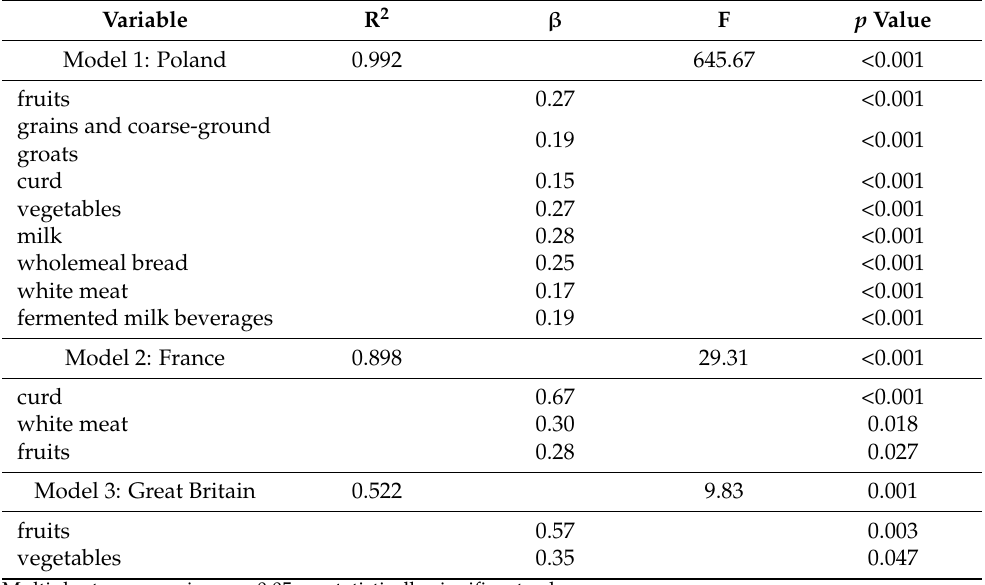
Table 5. Regression analysis predicting diet quality in masters athletics from Poland, France, and Great